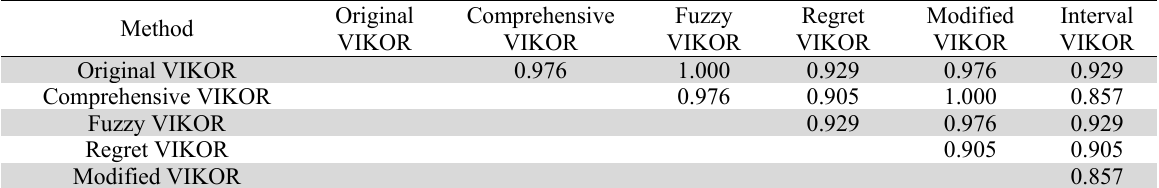
Comparison of ranking patterns for VIKOR method and its variants Method Comprehensive